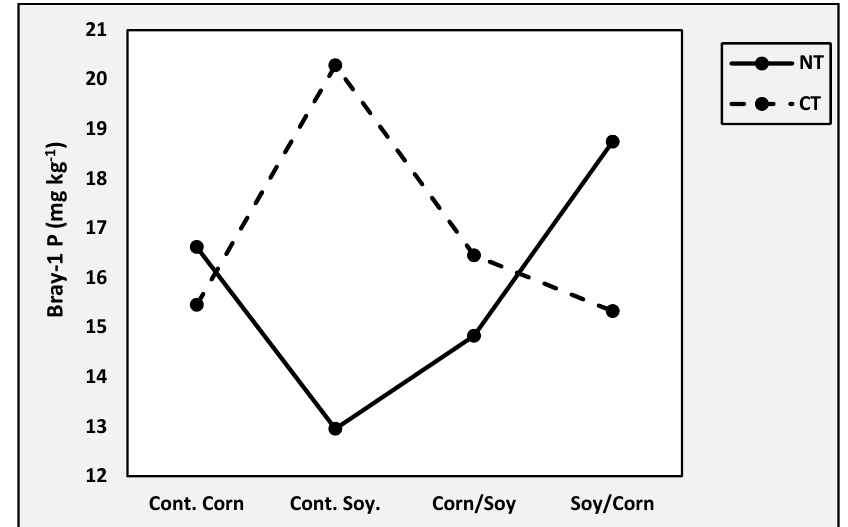
Figure 5. Effects of crop rotation x tillage interaction on Bray 1 P in 2013. Please note that NT = no tillage; CT = conventional (moldboard plow).